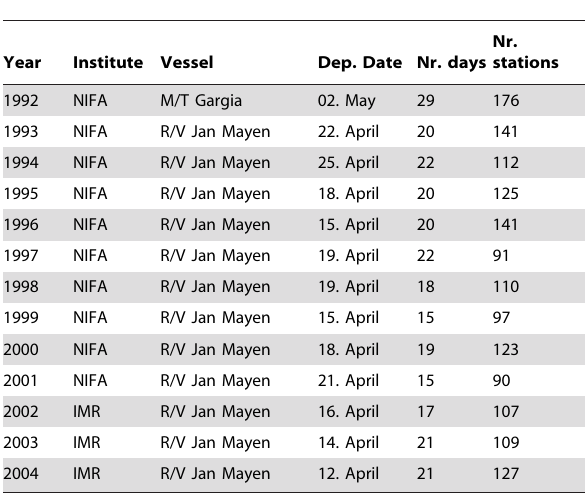
Table 1. Survey year, vessel used, institution in charge (NIFA: Norwegian Institute of Fisheries and Aquaculture, IMR: Institute of Marine Research), departure date, number of survey days and number of stations